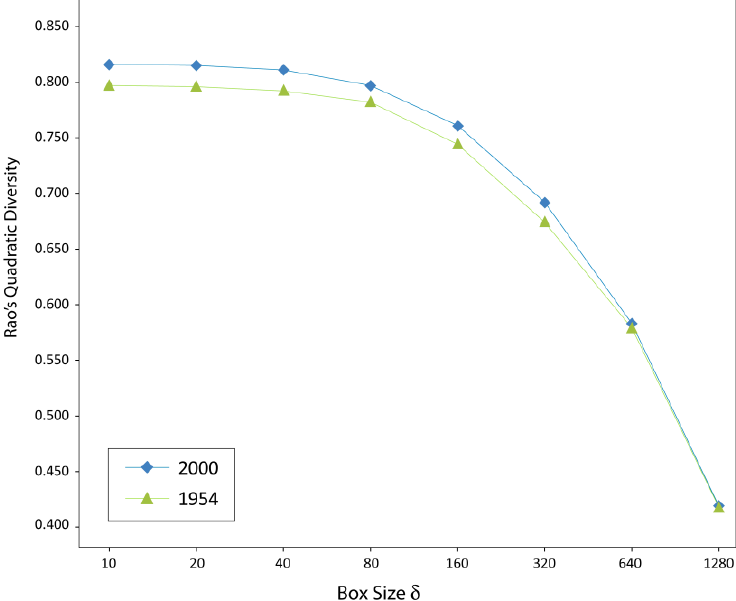
Figure 3. Plot of the Rao index Q vs. box size, δ, for the land cover maps of Isernia in 1954 and 2000 extending from δ = 10 m up to δ = 1,280